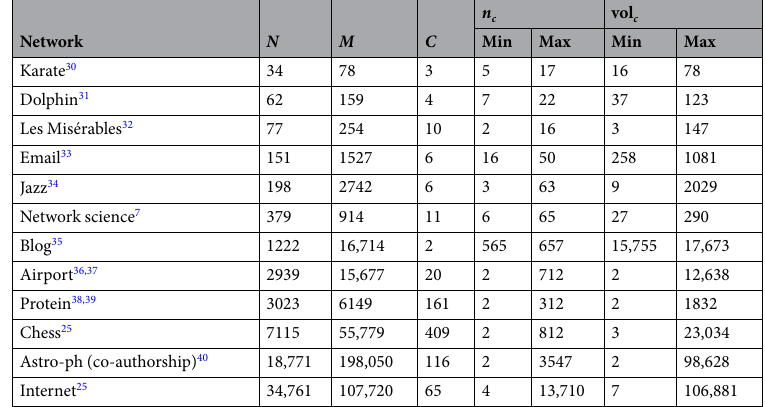
Table 1. Properties of 12 empirical networks. Column C indicates the number of communities detected by the Louvain algorithm. Columns